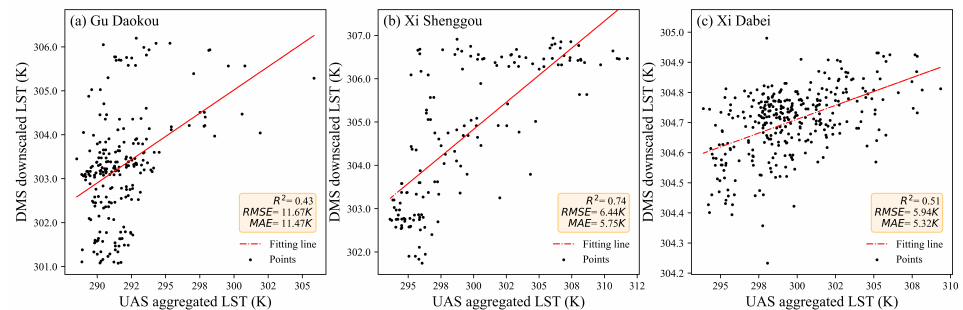
Figure 7. Scatterplots of the UAS aggregated LST and DMS downscaled LST at three flight